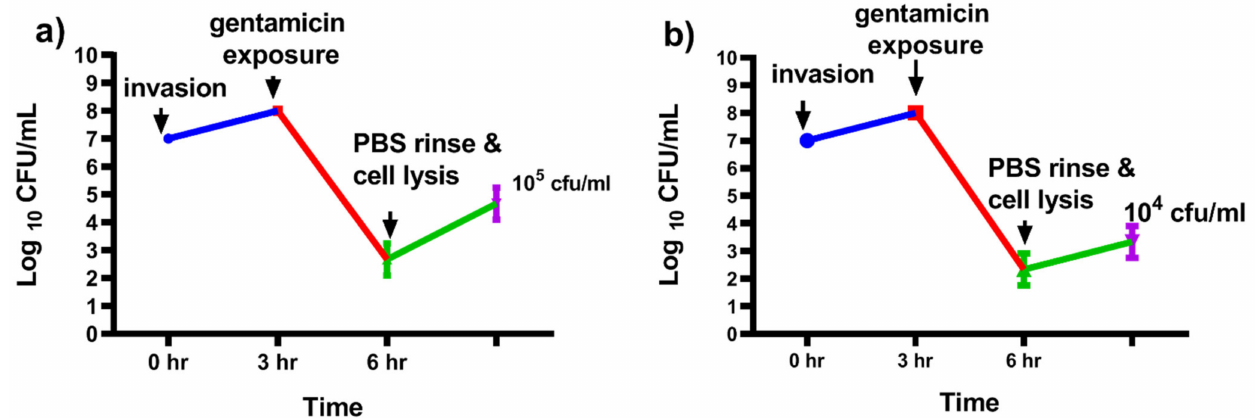
Figure 4. Intracellular survival of S. aureus in Mac-T cells. Following gentamicin exposure, lysis of Mac-T cells released approximately 10 5 CFU/mL of S. aureus ( a ) 15 AL and ( b ) 10 4 CFU/mL of F3 3D. Error bars represent the standard deviation (SD) of triplicates.